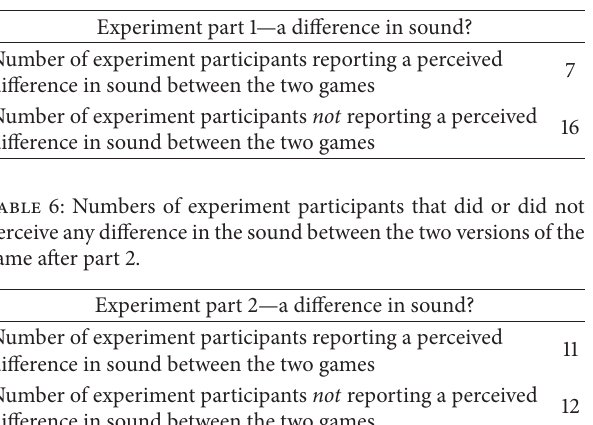
Table 5: Numbers of experiment participants that did or did not perceive any difference in the sound between the two versions of the game after part 1.